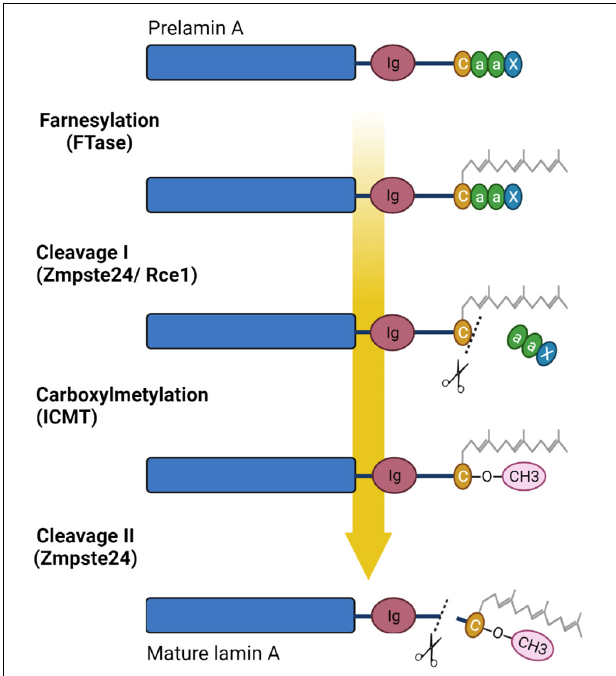
FIGURE 3 | Processing of prelamin A. Prelamin A undergoes four steps of reaction to become mature lamin A: farnesylation of cysteine of CaaX box by farnesyltransferase enzyme (FTase), cleavage of aaX by the zinc metalloprotease Zmpste24 (FACE1) or RAS converting enzyme 1 (Rce1), carboxylmethylation of the farnesylated cysteine via the isoprenylcysteine carboxyl methyltransferase (ICMT), and finally cleavage of the 15 terminal amino acids, including the farnesylated and carboxymethylated cysteine, by ZMPSTE24. Created with